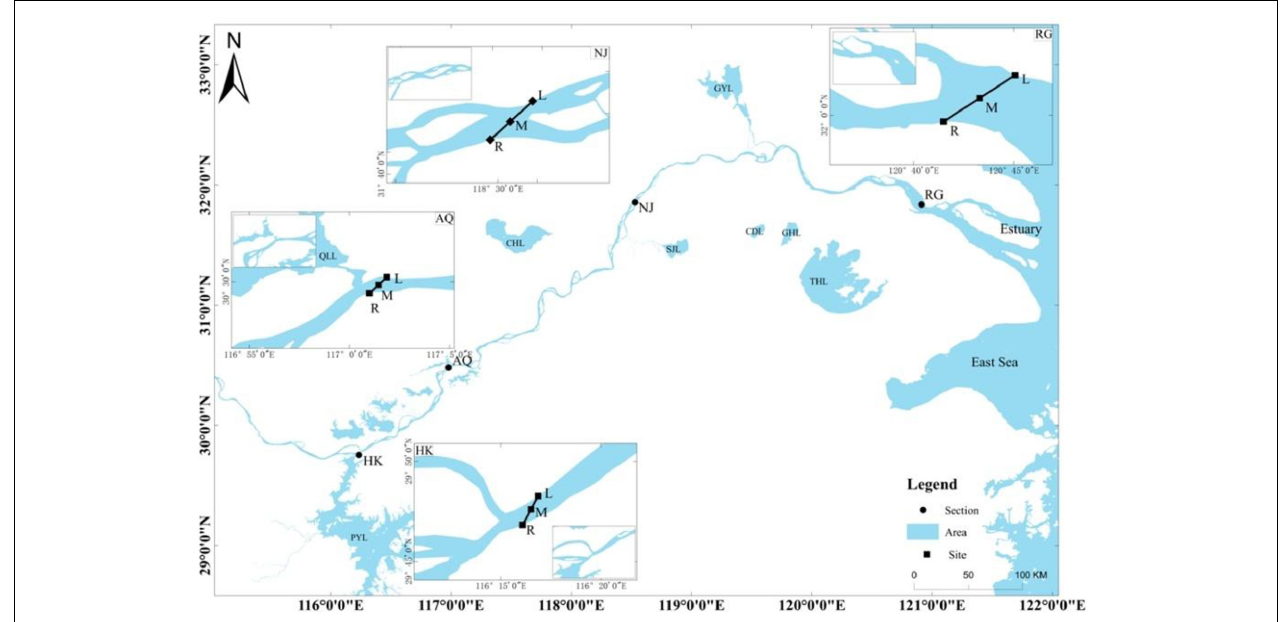
FIGURE 1 | Sampling sites for ichthyoplankton in the Changjiang River. Four sections were set in the lower reach of the Changjiang River. HK, Hukou; AQ, Anqing; NJ, Nanjing; RG, Rugao. Three sampling sites were set in each section: the right bank (R), the left bank (L), and the middle (M). PYL, Poyang Lake; WR, Wan River; QLL, Qili Lake; CHL, Chaohu Lake; SJL, Shijiu Lake; GYL, Gaoyou Lake; CDL, Changdang Lake; GHL, Gehu Lake; THL, Taihu